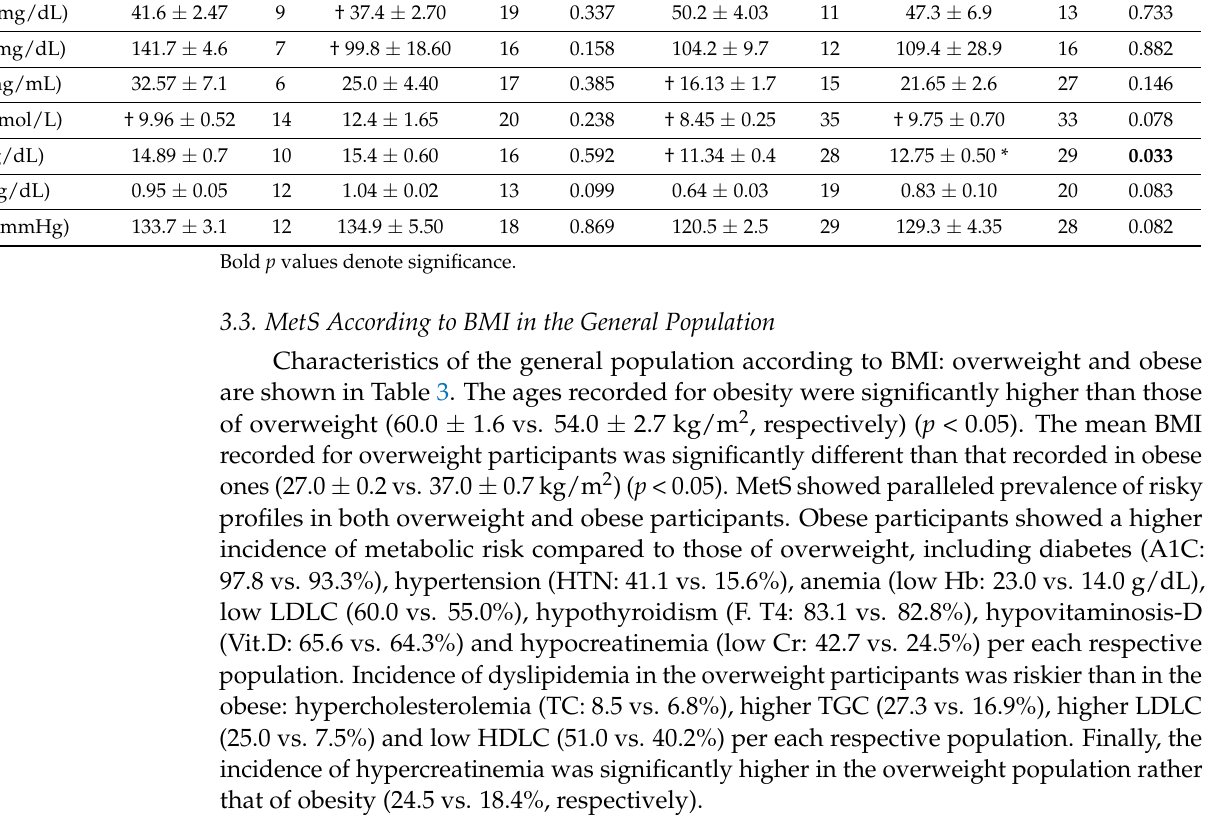
Table 3. Characteristics of the general population according to body mass index (BMI):